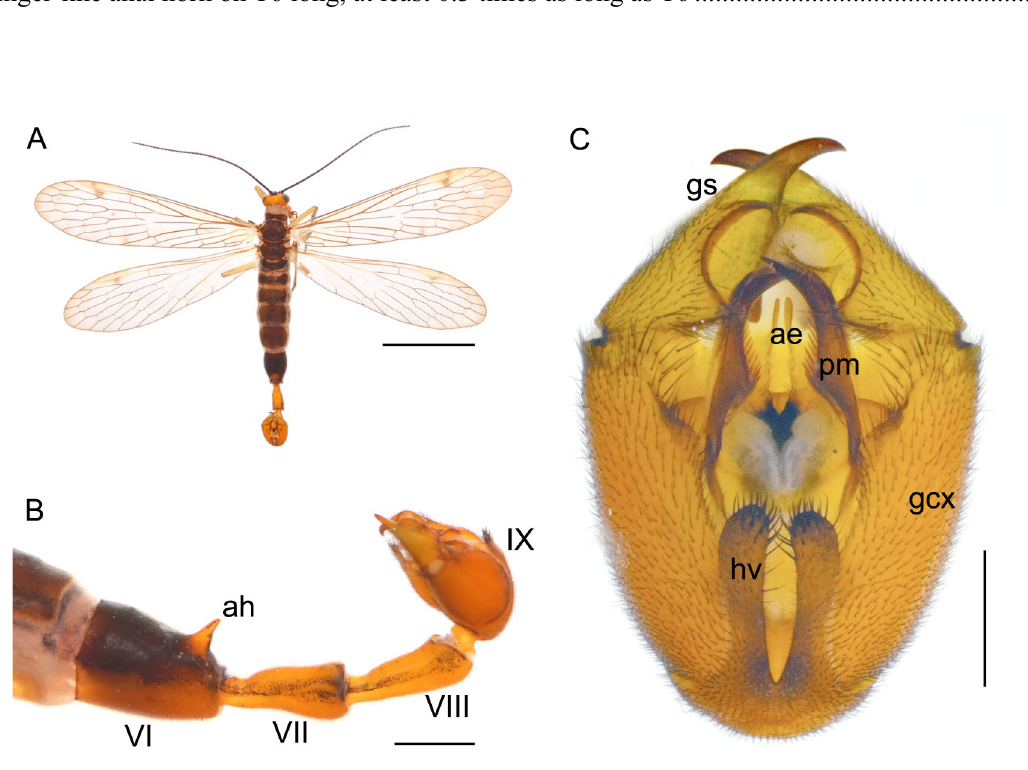
Fig. 4. Panorpa horiensis Issiki, 1929, male from Taiwan, China. A . Habitus in dorsal view. B . Abdomen in lateral view. C . Genital bulb in ventral view. Abbreviations: ae = aedeagus; ah = anal horn; gcx = gonocoxite; gs = gonostylus; hv = hypovalve; pm = paramere. Scale bars: A = 5 mm; B = 1 mm; C = 0.5